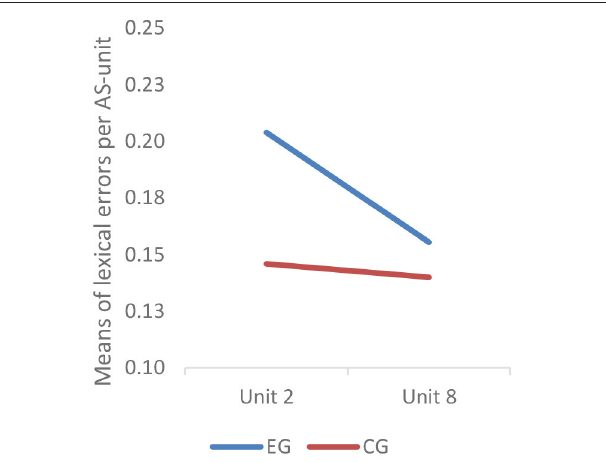
FIGURE 7 | Profile plot of speed fluency. Covariates appearing in the model are evaluated at the following values: placement test score = 83.05.